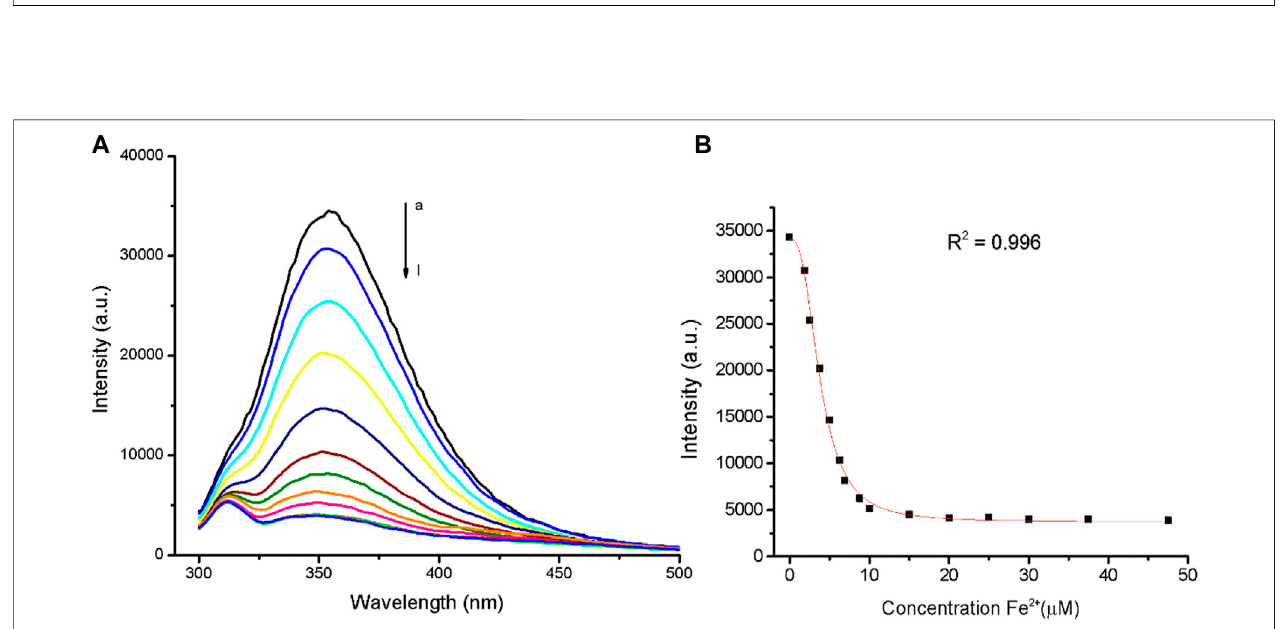
FIGURE 2 | Quenching effects of Fe 2+ on TanP (1.12 μ M) fl uorescence intensity, with λ ex (cid:2) 280 nm. (A) Addition of iron ion, curves a – l (0 – 47.7 μ M). (B) Fluorescence intensity of TanP at 353 nm with increased Fe 2+ .